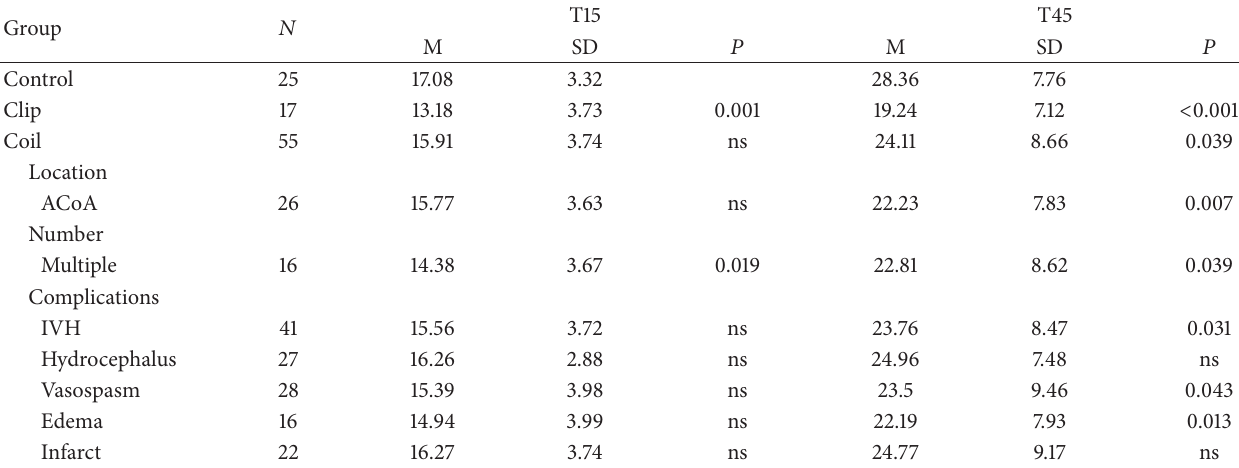
Figure 1: Number of words produced in the first 15 and last 45 seconds of the phonemic fluency test (a) and semantic fluency test (b). ∗ Significantly impaired compared to healthy control subjects ( 𝑃 < .05 ). Table 2: Initial (T15) and late phase (T45) word production compared to healthy